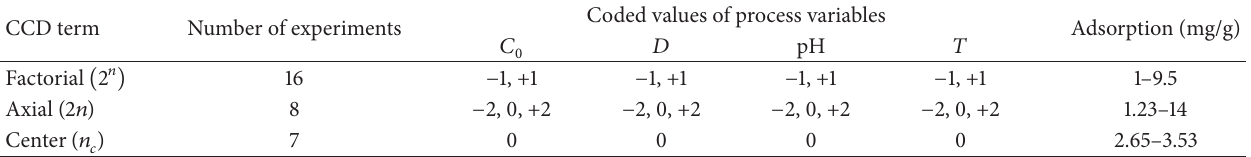
Table 3: Central composite design (CCD) for the four independent variables and corresponding dye adsorption (mg/g).